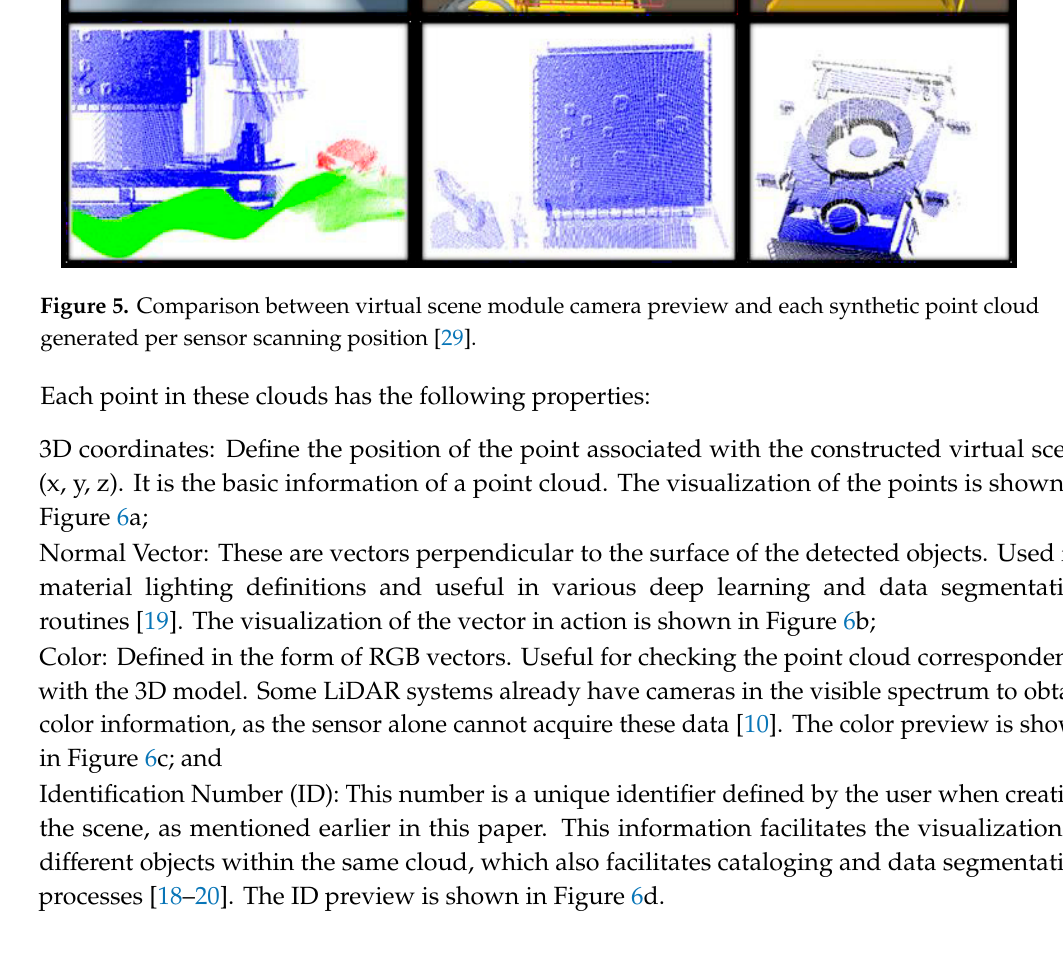
( d ) Figure 6. Different properties of the synthetic point cloud: ( a ) 3D points; ( b ) Normal vectors; ( c ) Color; ( d ) ID [29].